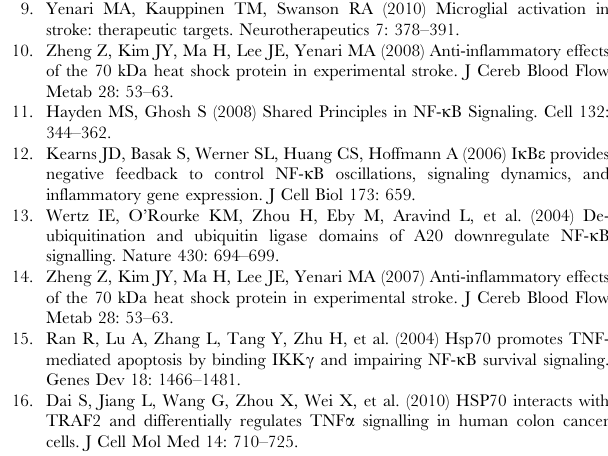
Figure S3 Simulations of additional downstream Hsp72 interactions. Results of simulated Hsp72 interactions occurring downstream at the level of the I k B a :NF- k B complex showing the response of the species shown in the column heading. A. Inhibition of phosphorylation by IKK ( kc2a ). B. Inhibition of proteasomal degradation ( kupd ). C. Inhibition of E3-ligase recruitment to Figure S4 Simulations of additional implausible sce- narios of Hsp72 regulation. Simulation results showing scenarios of Hsp72 regulation that are inadequate to account for key experimental observations in addition to those shown in the main text. A. Reduction of only total IKK concentration by the factor shown at right cannot reduce amount of basal total I k B a . B. Reduction of initial IKK by 1/8 and downstream (DS) inhibition of I k B a phosphorylation rate ( kc2a set to 1/5 nominal value) cannot reduce basal I k B a . C. Reduction of total p65 and only inhibition of DS signaling component ( kc2a set to 1/10 nominal value) is not able to reduce IKK activation. Figure S5 Simulations of additional plausible scenarios of Hsp72 regulation. Simulation results showing scenarios of Hsp72 regulation that include the necessary components and may be plausible. Models that include total p65 reduced by 70% plus the additional mechanisms specified. (A–D) DS denotes inhibition of the I k B a phosphorylation rate ( kc2a ). Figure S6 Simulation results consistent in presence of parameter uncertainty. Simulations in the main text were repeated assuming that model parameters and initial conditions are uncertain, distributed uniformly in an interval + / 2 20% centered around the mean. Simulations were performed using 100 randomly sampled parameter sets and averaged for comparison. Thin lines indicate results from random samples, while thicker lines show the average response. Blue indicates parameters centered around the nominal set used to model control cells; red indicates parameters centered around the modified parameters assumed to be altered by Hsp72. A. Modified parameter ka to 1/16 of the nominal value;